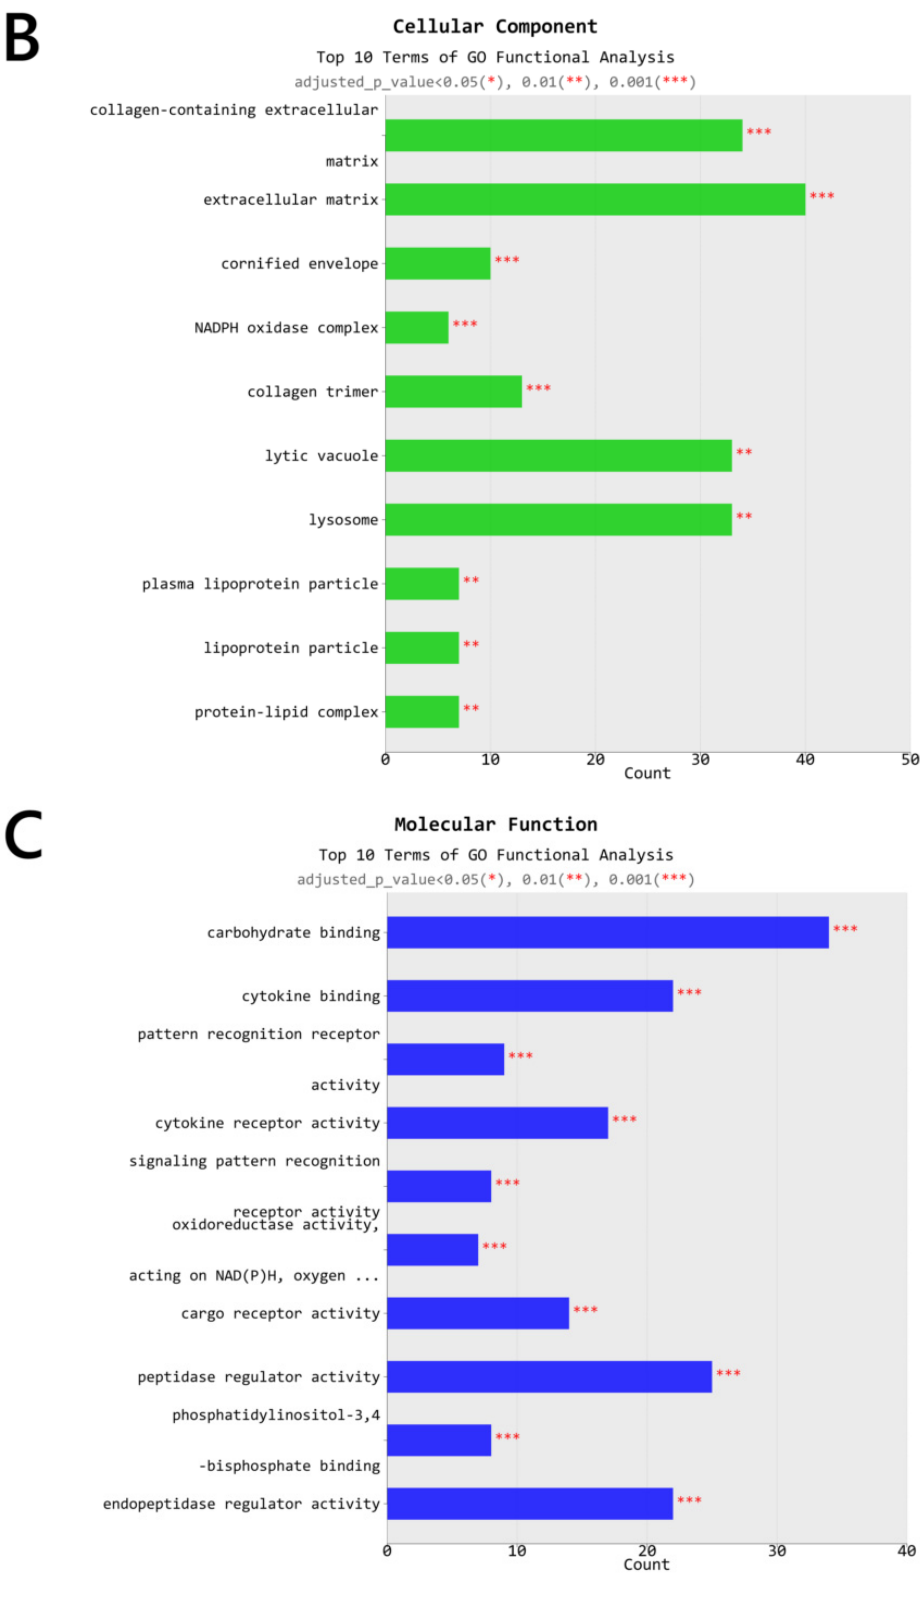
Figure 6. The major gene ontology (GO) terms and pathways of OVA + PM vs. OVA group. ( A ) Biologic process, ( B ) Cellular component, ( C ) molecular function.